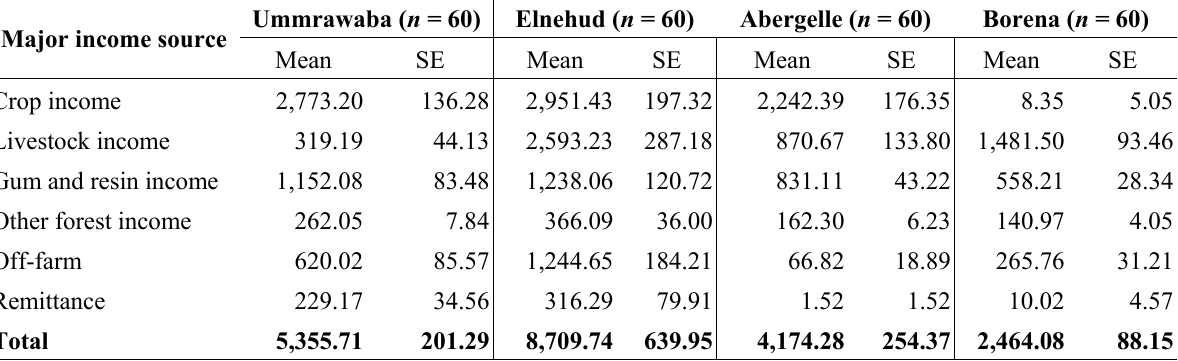
Table 2. Households’ livelihood portfolio (US$ PPP) in the four case study